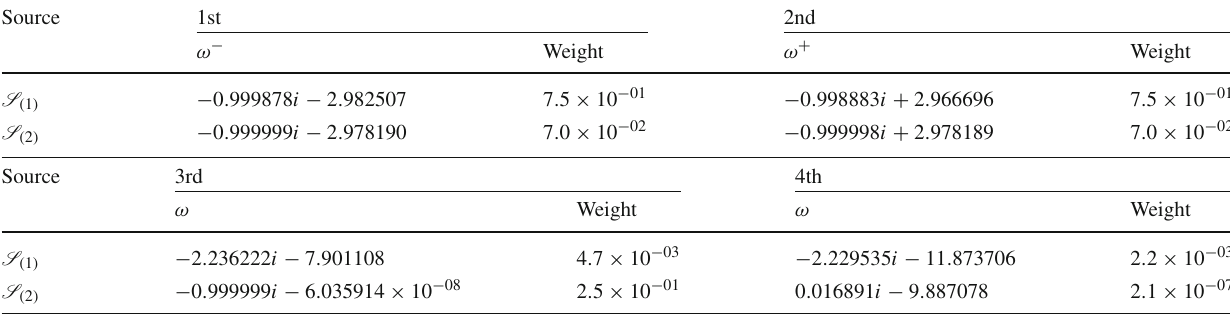
Table 1 The calculated quasinormal frequencies by using the Prony method for the source terms Eqs. (35) and (36). The numerical code has been implemented to extract five modes while the first four most dominante ones, as well as their respective amplitudes, are listed Source 1st 2nd ω − Weight ω +